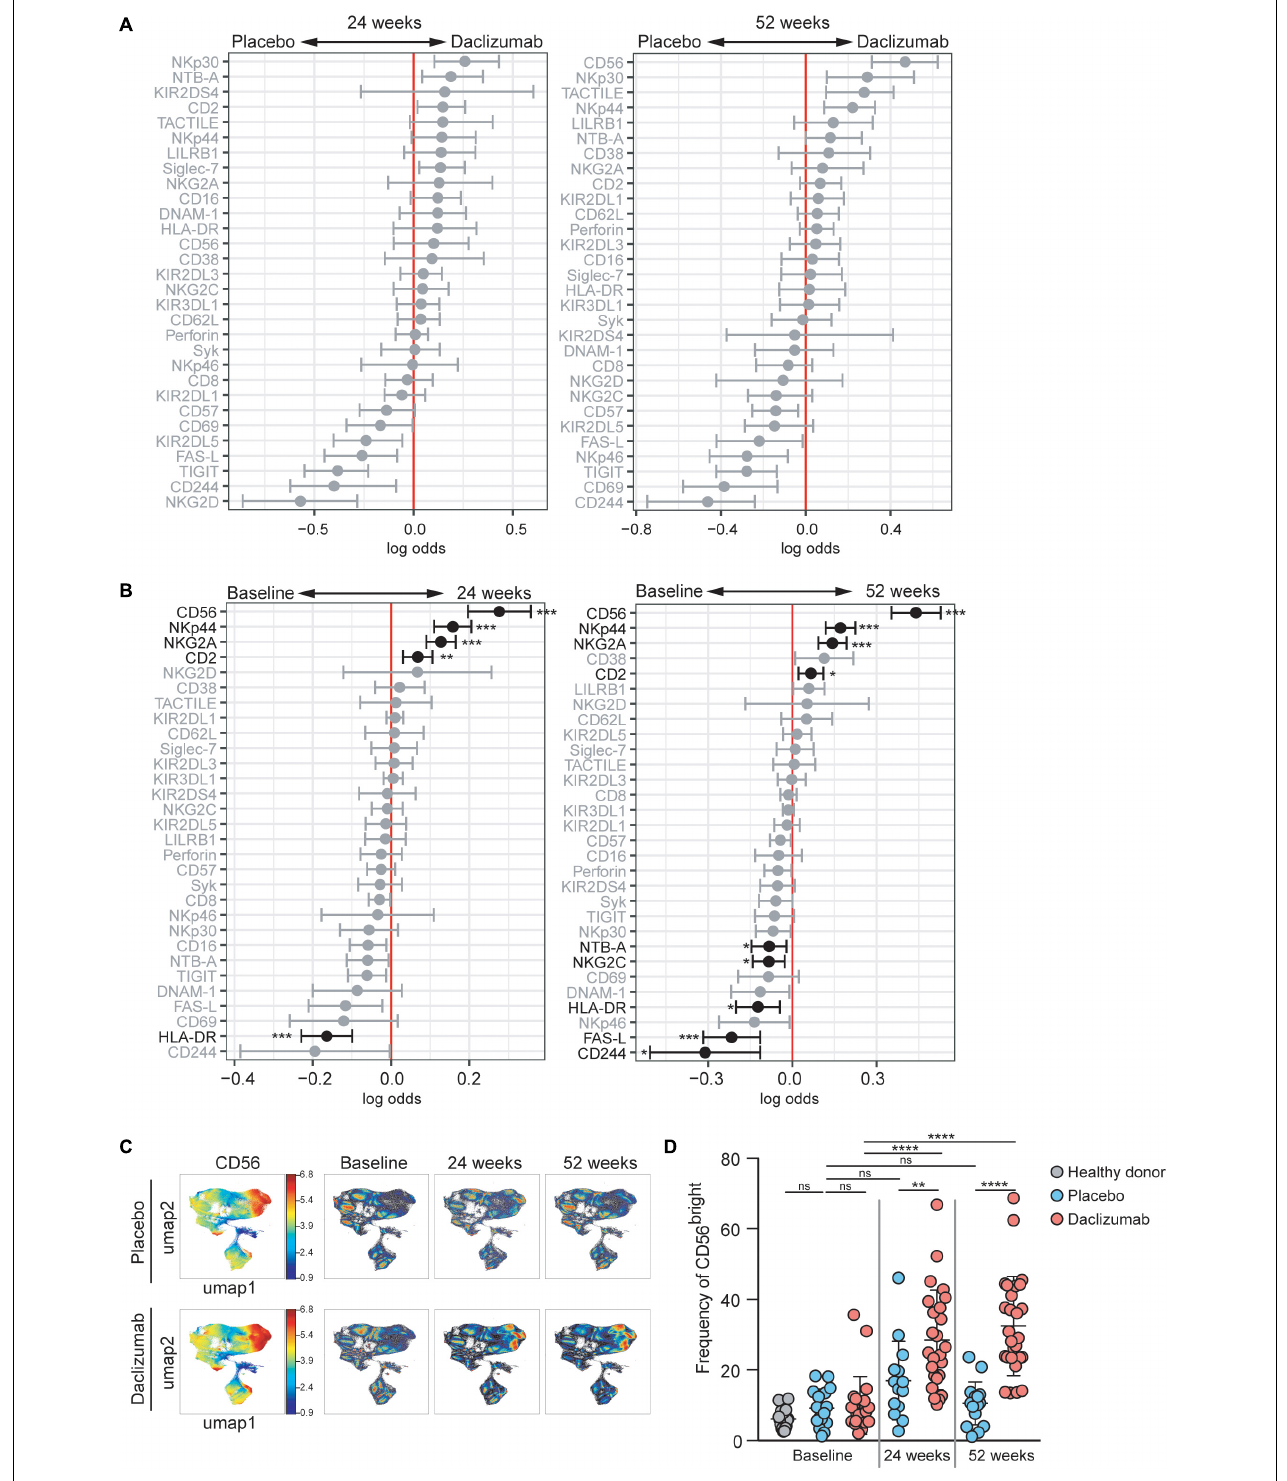
FIGURE 1 | Daclizumab beta induces CD56 bright NK cells with a distinct phenotype . (A) A generalized linear model with bootstrap resampling was used to identify NK markers predictive of daclizumab beta- and placebo-treated individuals at 24 (left) and 52 (right) weeks of treatment. Log-odds are logarithm of ratios of the probability that a cell belongs to each treatment group. An increase in the parameter coefficient corresponds to the strength of the classification power, with the 95% confidence interval represented by the line surrounding the point estimate. Gray lines indicate markers with adjusted p -values > 0.05. Black lines indicate